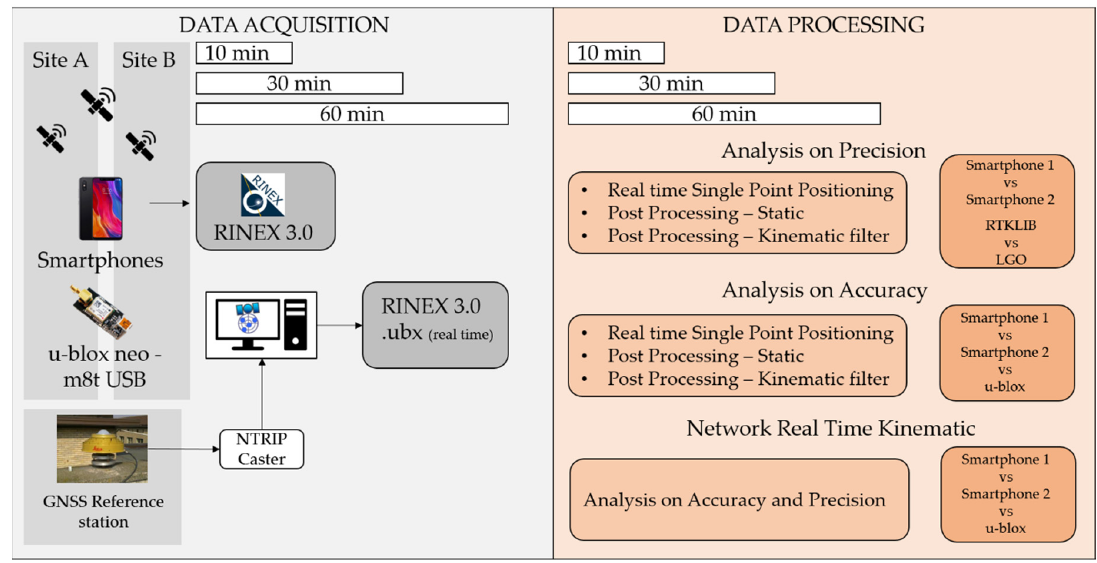
Figure 2. Synthetic outline of the data acquisition and data processing procedures.